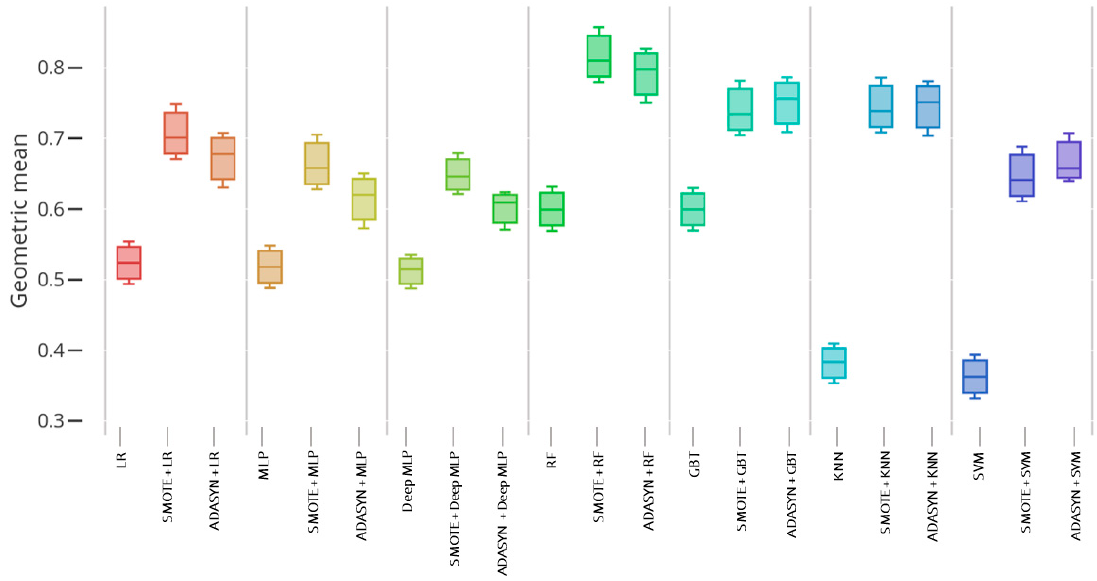
Figure 4. Boxplot of the geometric mean over prediction models among men.